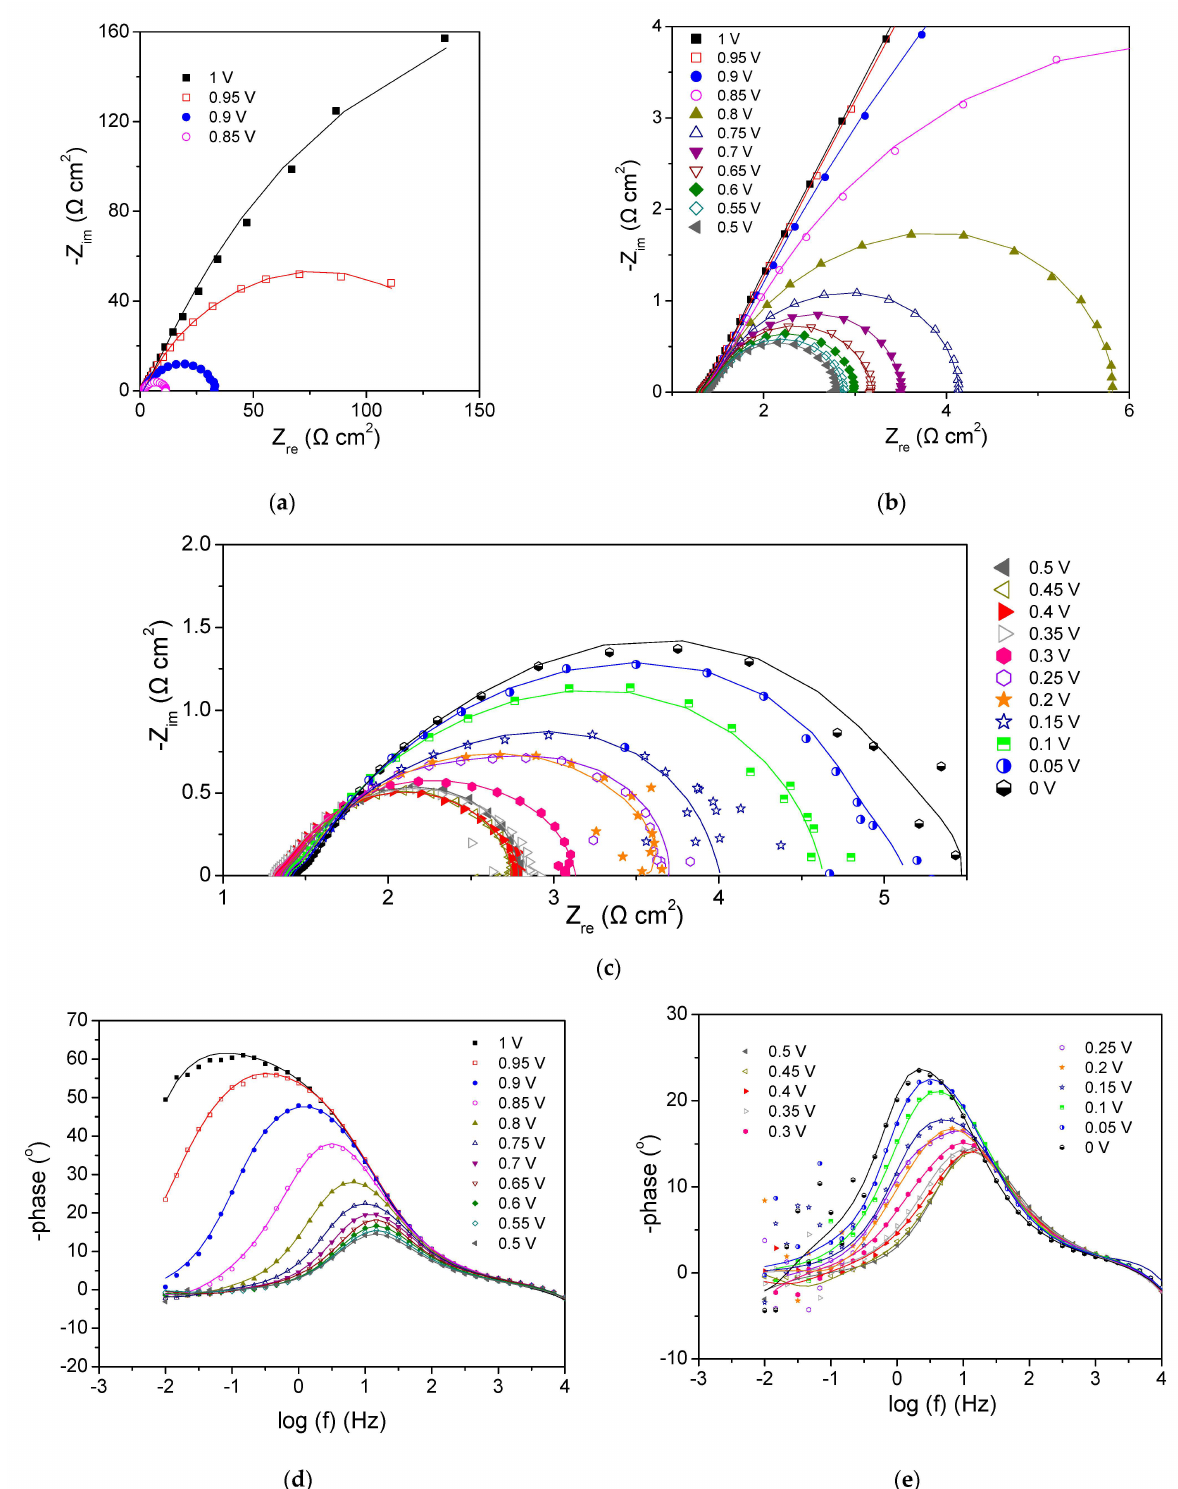
Figure 7. Effect of cell potential U fc on the EIS characteristics of the PEMFC with the 29Pt (TKK) cathode electrode, presented in the form of Nyquist plots ( a – c ) and negative phase an- gle vs. log(frequency f ) Bode plots ( d , e ); Flow rates: F anode (100% H 2 ) = F cathode (synthetic air) = 100 cm 3 min − 1 ; geometric electrode surface area, A elec = 5.29 cm 2